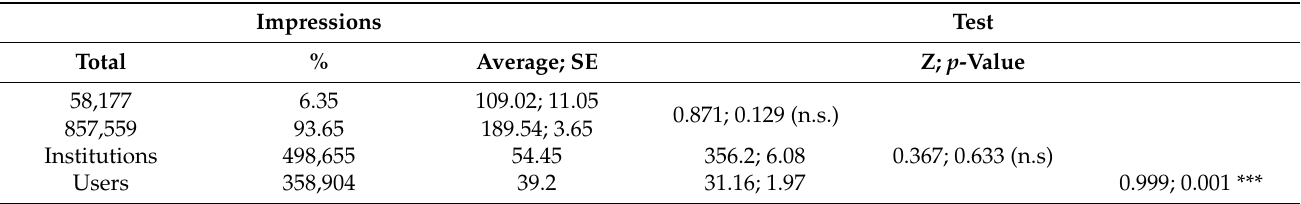
Table 3. Impressions generated by users identified in #yomevacuno